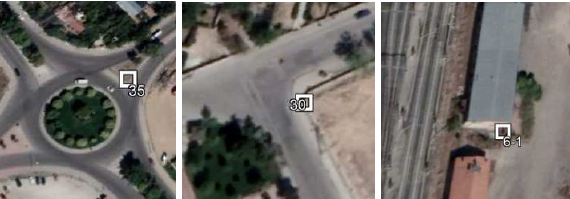
Figure 2. Some examples for created object based